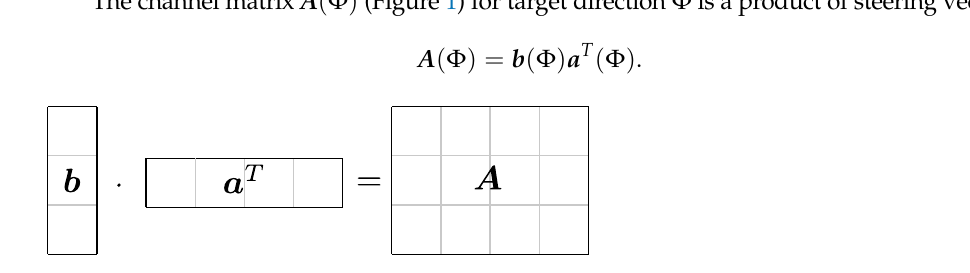
Figure 1. Channel matrix as a product of the steering vectors.